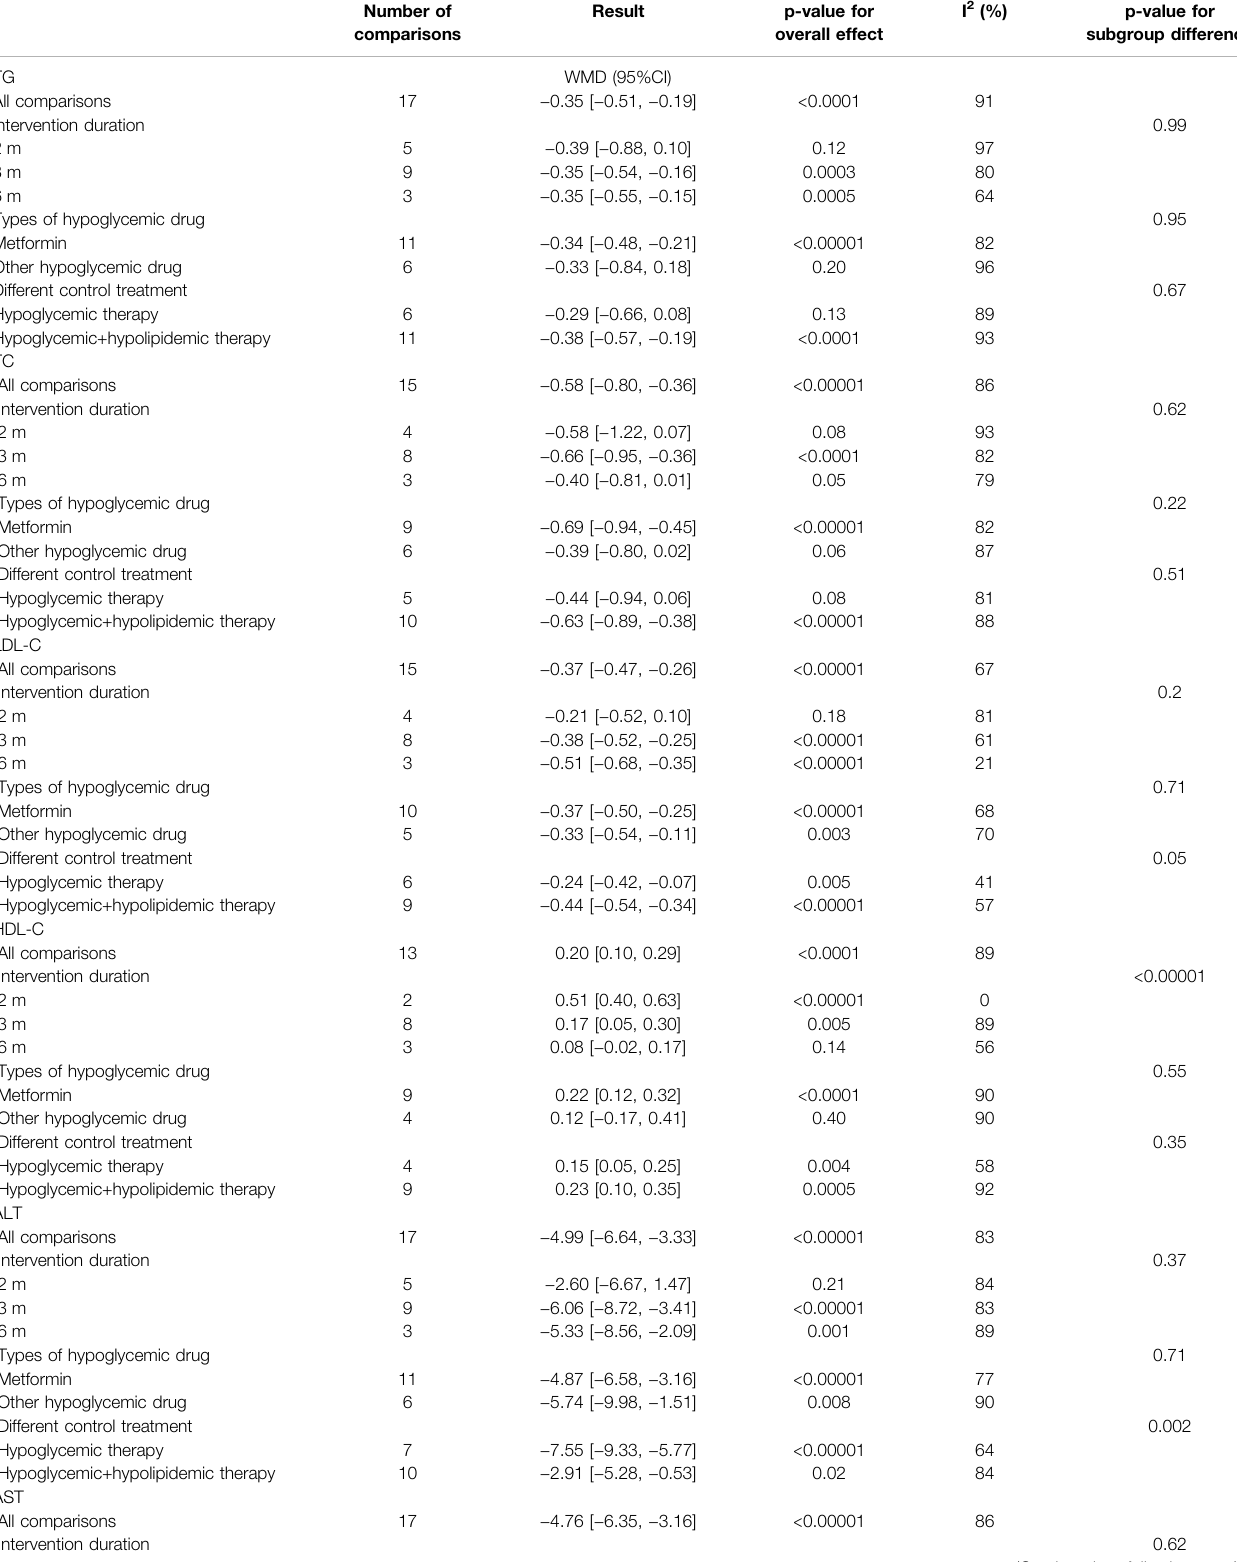
TABLE 3 | Subgroup analysis for